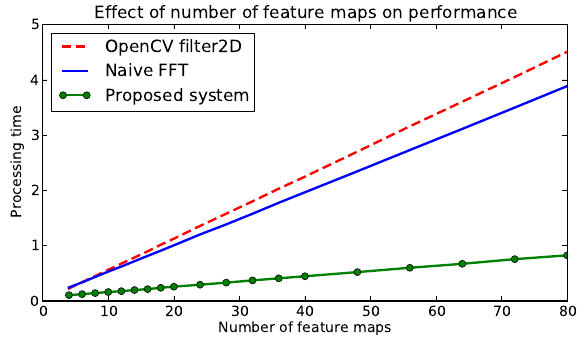
(a) Effect of kernel size on performance. Square kernels are used with sizes equal to the number on the x-axis. The number of fea- ture maps is set to 48 , and the number of classes to 20 . Note that the filter2D implementation automatically switches to an FFT- based implementation for kernels larger than 10 × 10 pixels.